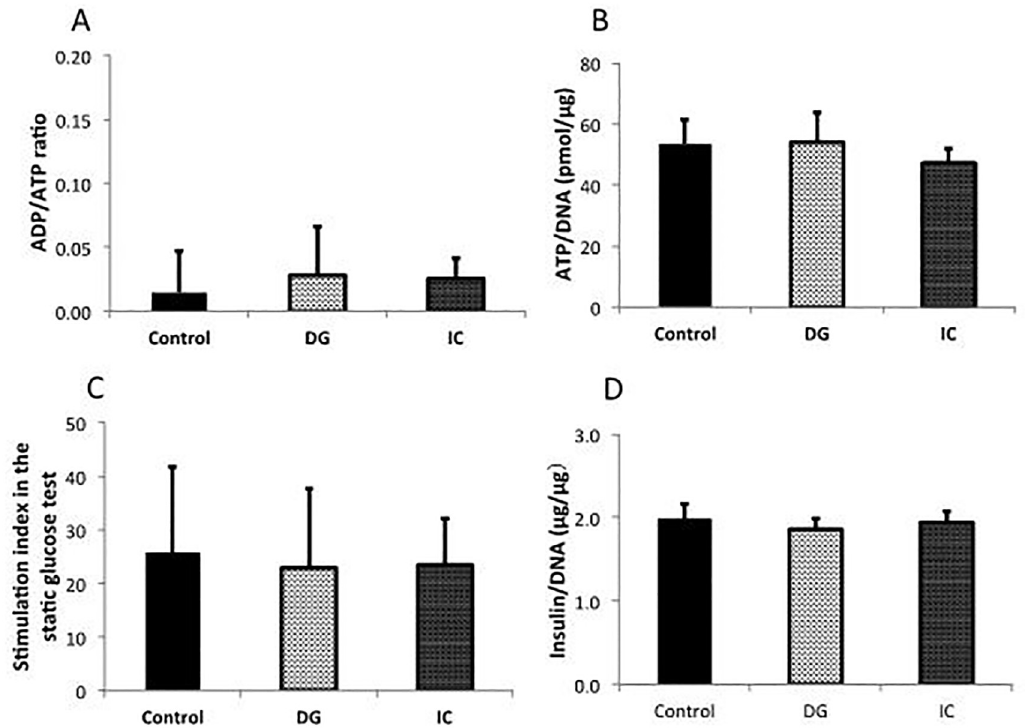
Fig 4. Influence of each dye on the viability and function of isolated rat islets. (A) ADP/ATP ratio, (B) ATP/DNA ratio, (C) stimulation index in the static glucose stimulation test, and (D) insulin/DNA ratio. No significant differences were observed among the